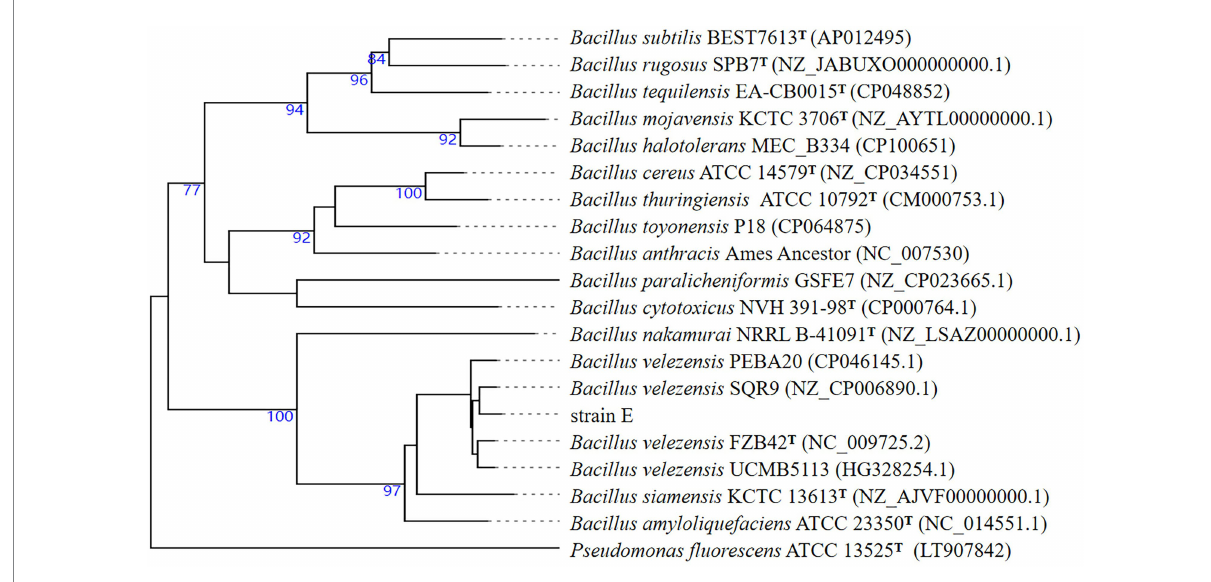
TABLE 3 Pairwise dDDH and orthoANI values between strain E and other Bacillus strains. Bacterial strains OrthoANI (%) dDDH (%)